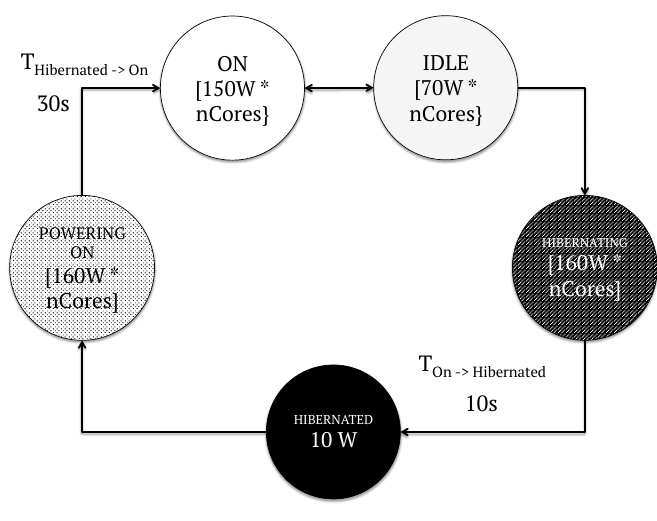
Figure 5. Machine power states [52].